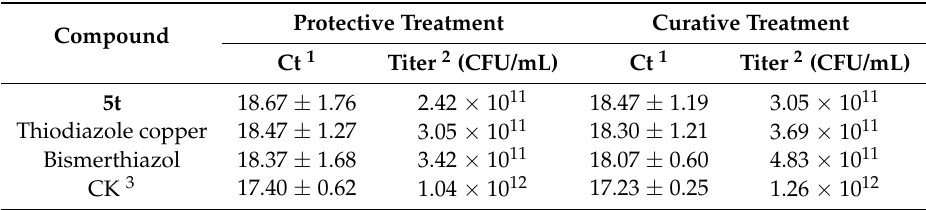
Table 7. The Xoo titer in the rice leaves treated by compound 5t .